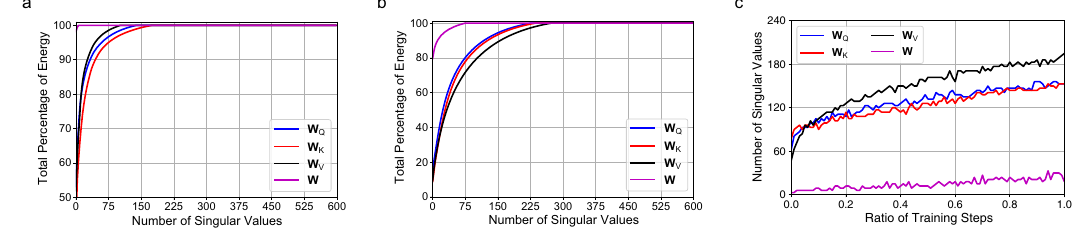
Fig. 4 Analysis of gradient energy distribution. a Cumulative energy distributions of singular values of different types of parameter gradient matrices at the beginning of model training. b Cumulative energy distributions of singular values at the end of model training. c Evolution of the number of required singular values during model training under a singular value energy cutoff threshold T = 0.95. W Q : query parameters, W K : key parameters, W V : value parameters, W : feed-forward network parameters. The results show that the gradients are usually low-rank, and they have more high-frequency components after more rounds of model training. Thus, a relatively higher energy threshold needs to be used to keep higher gradient precision at the end of model training for better model